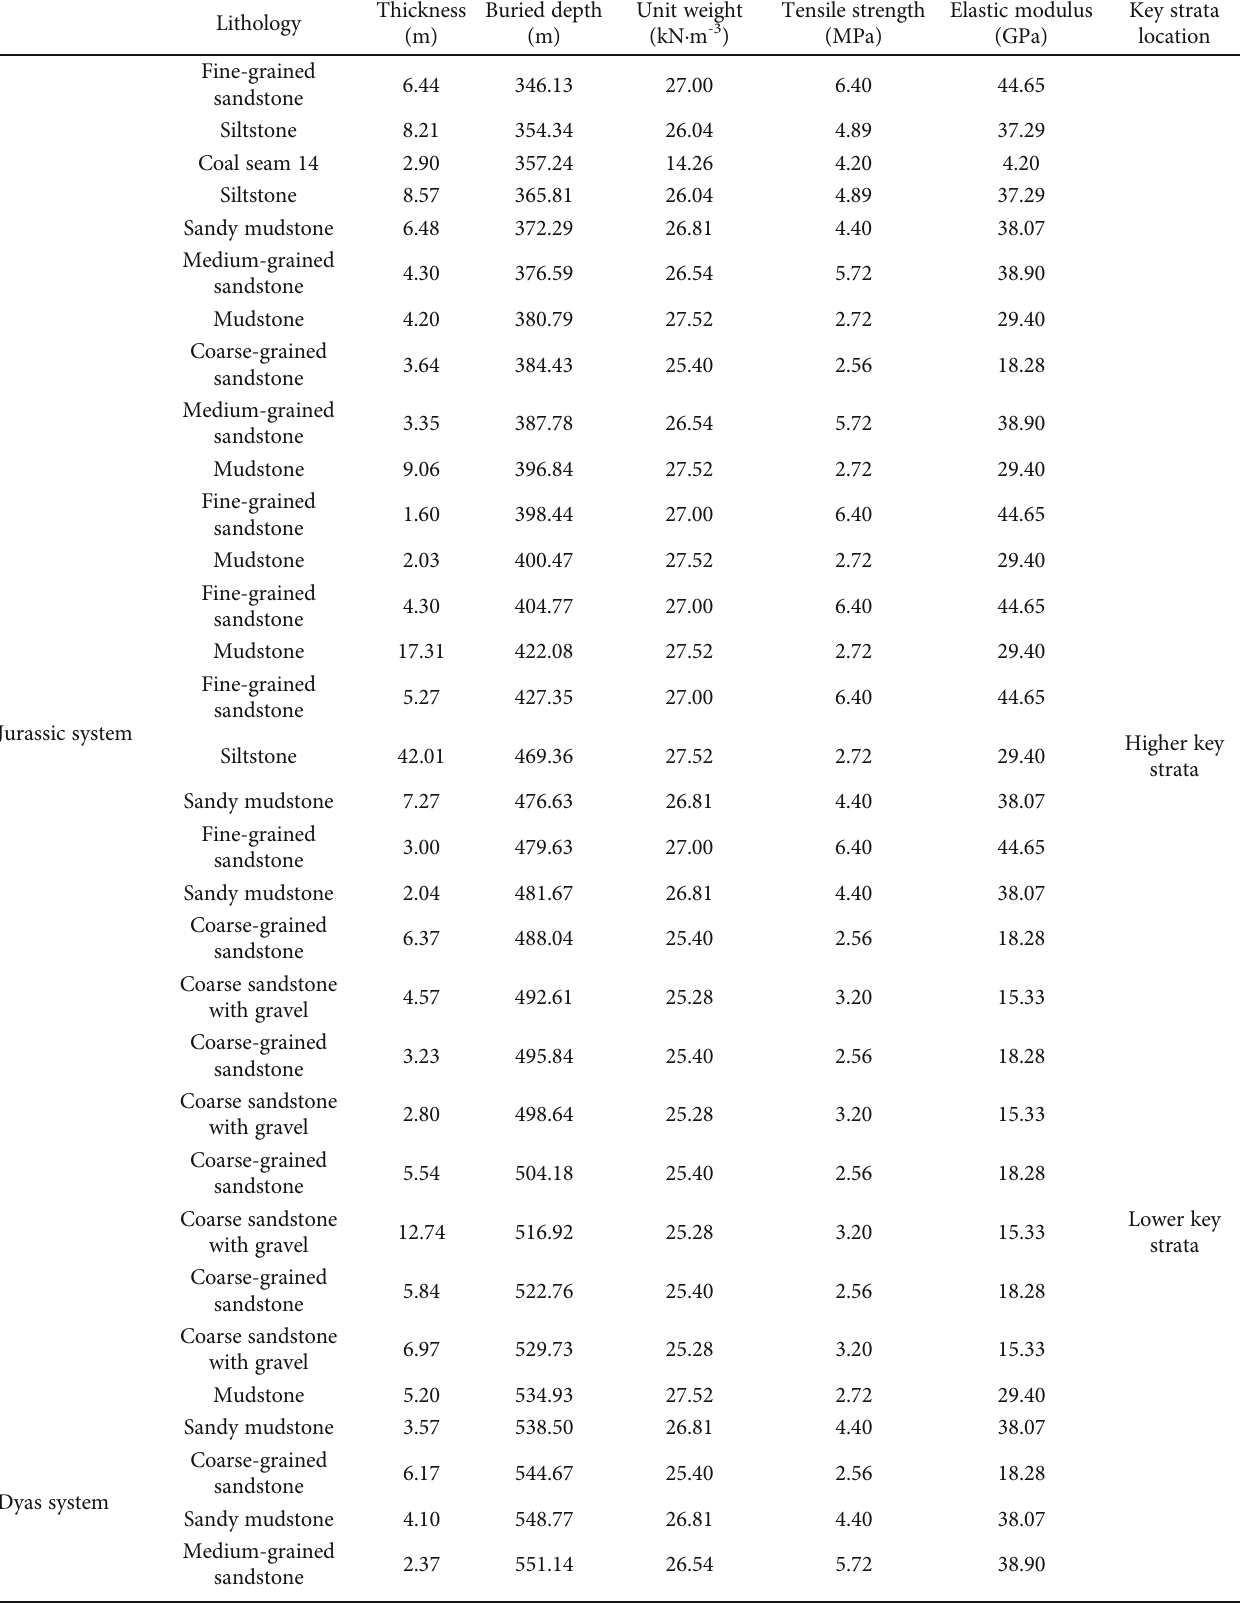
Table 1: Physical and mechanical parameters of 1# drill hole column and coal seams. Lithology